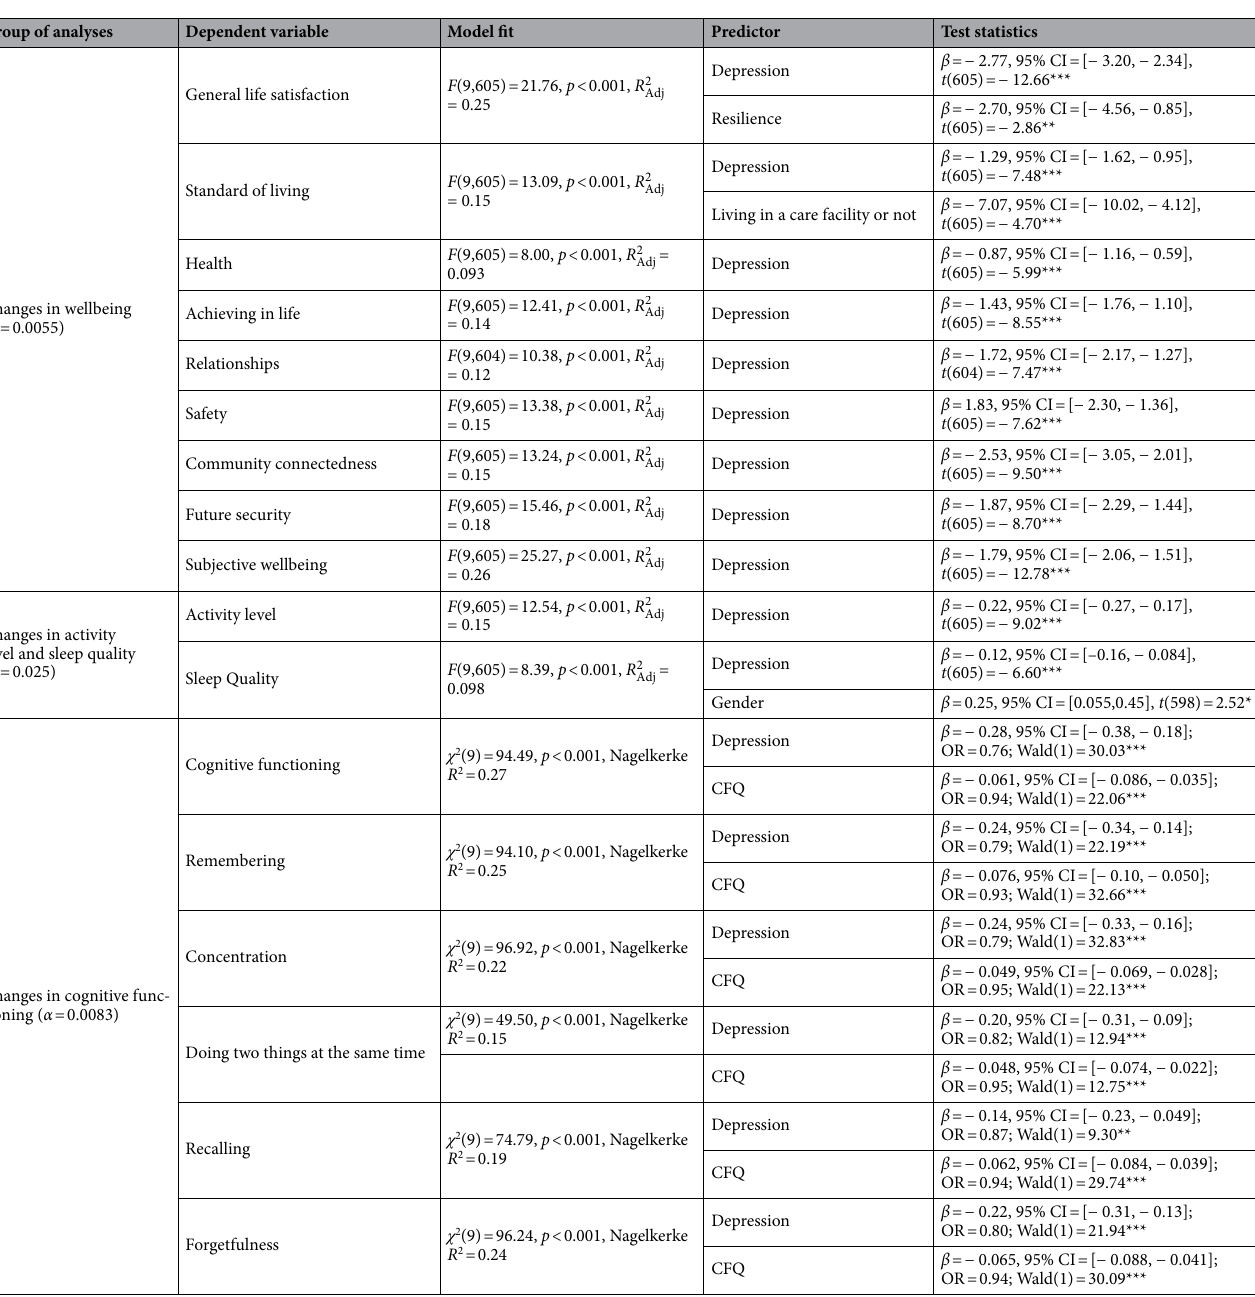
Table 3. Statistical results of the 17 linear and ordinal logistic regression analyses conducted for changes in wellbeing, activity level and sleep quality (all based on the calculated difference scores) and cognitive functioning (based on the subjective cognitive change questions) with gender, age, whether the participant lived alone or not, whether the participant lived in a care facility or not, monthly individual net income, depression (i.e., GDS-15 total score), social network (i.e., LSNS-6 total score), general susceptibility to cognitive failures (i.e., CFQ total score) and resilience (i.e. BRS total score) as predictors. Both the fit of the full model (Model fit) and the test statistics for the significant predictors are reported. Only predictors that contributed significantly to the model are reported; OR = odds-ratio; * p < 0.02; ** p < 0.005; *** p <